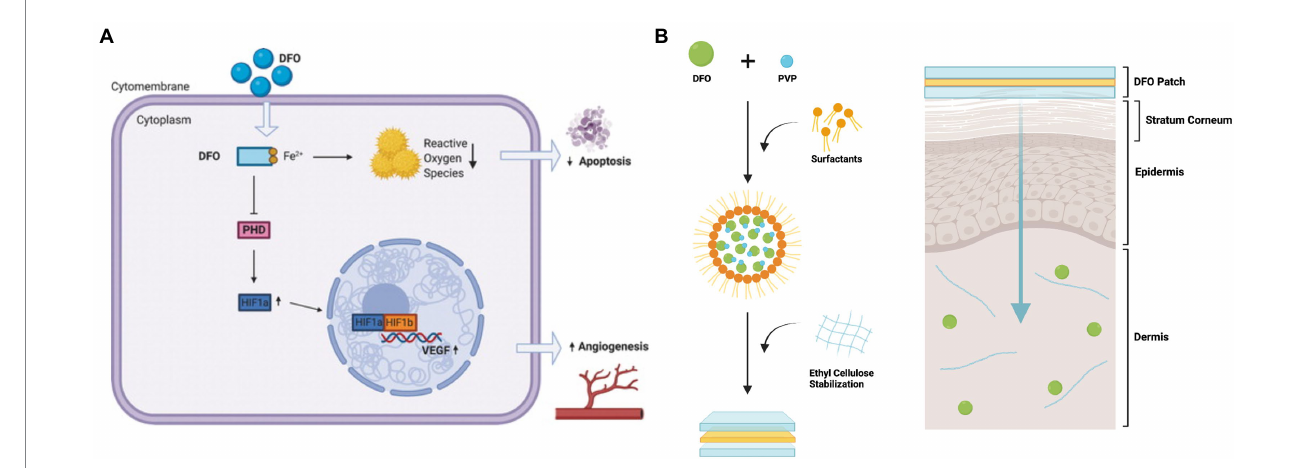
FIGURE 1 Deferoxamine (DFO)‘s potential mechanism of action and schematic of the transdermal drug delivery system for DFO. (A) After treatment, DFO leads to decreased cellular iron availability, which leads to increased VEGF mRNA expression and protein. With the removal of iron, a necessary cofactor for PHD, PHD is inactivated and no longer able to degrade HIF-1 α . Accumulation of HIF-1 α leads to activation of the HIF1 heterodimer, and triggers downstream effectors in angiogenic pathways, such as VEGF transcription and translation. DFO also reduces free radical formation and reactive oxygen stress catalyzed by iron, and thus diminishes apoptosis. Reproduced with permission from Tevlin et al. (26). (B) DFO is aggregated with PVP and surfactants, forming reverse micelles (RM). These RM are then stabilized in ethyl cellulose. When the patch is placed on the skin, the RM are released from the ethyl cellulose matrix and can diffuse through the hydrophobic stratum corneum. The RM then break down, releasing the DFO-PVP aggregates. The PVP then dissolves, delivering DFO to the dermis. Figure adapted from Shen et al.